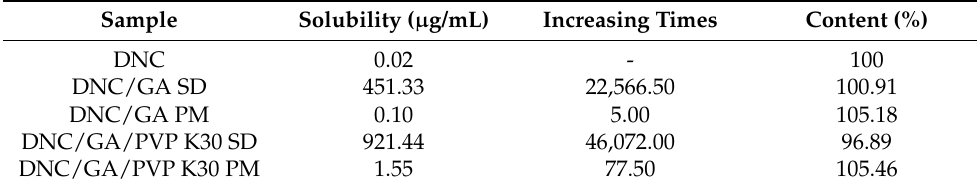
Figure 5. SEM images of ( a ) DNC, ( b ) GA, ( c ) PVP K30, ( d ) DNC/GA/PVP K30 PM, ( e ) DNC/GA/PVP K30 SD. Table 2. The water solubility of DNC SDs and DNC